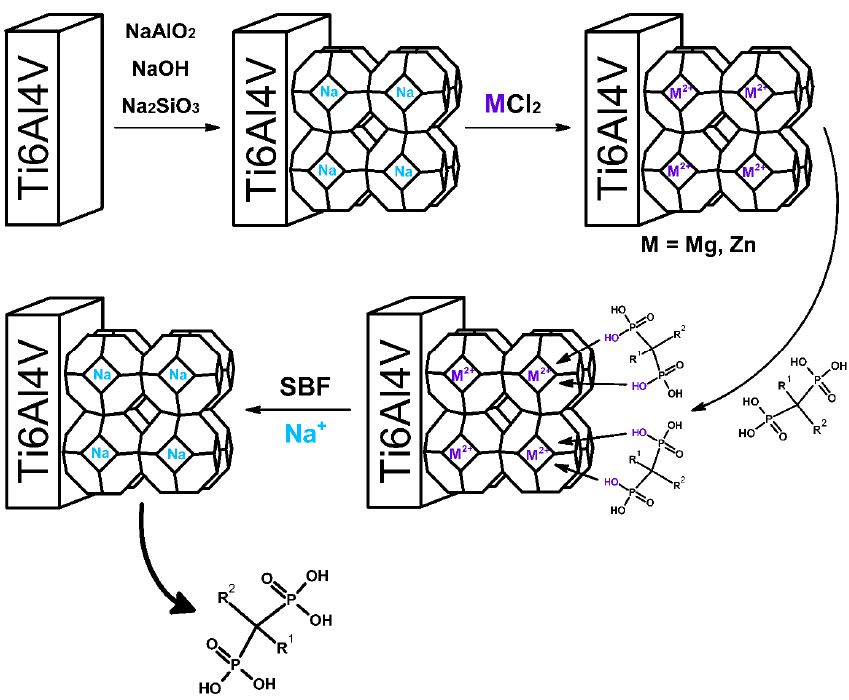
Figure 1. Scheme of drug release from titanium alloy modified with magnesium and zinc zeolite obtained in this work.